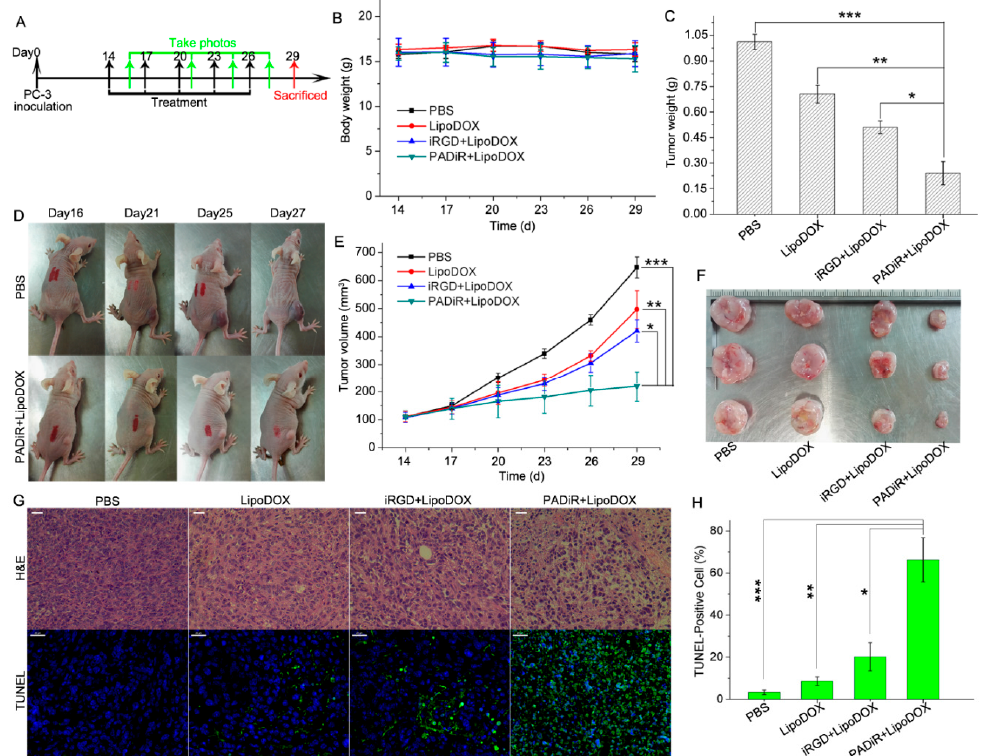
Figure 5. Improved antitumor effects of DOX ‐ loaded liposomes coadministered with PADiR Figure5. Improvedantitumore ff ectsofDOX-loadedliposomescoadministeredwithPADiRpeptosomes. peptosomes. ( A ) Scheme of PC ‐ 3 xenograft tumor therapy with peptosome coadministration; ( B ) body ( A ) Scheme of PC-3 xenograft tumor therapy with peptosome coadministration; ( B ) body weights